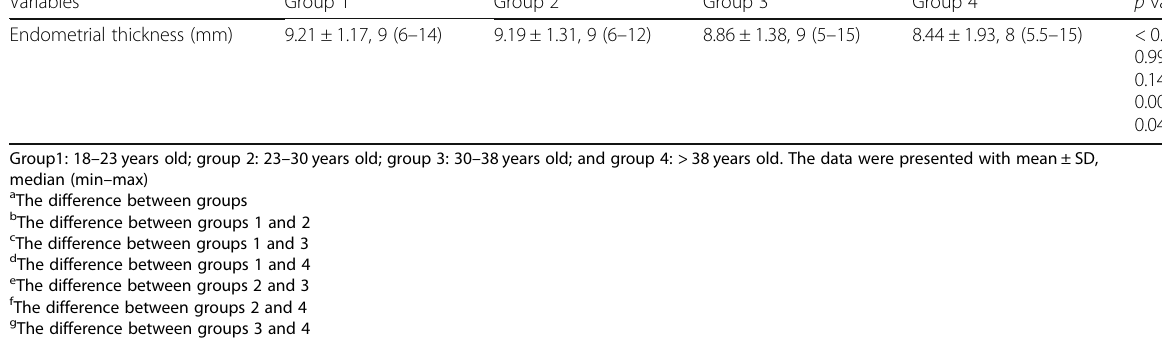
Table 4 Comparison of endometrial thickness between different age groups of pregnant patients Variables Group